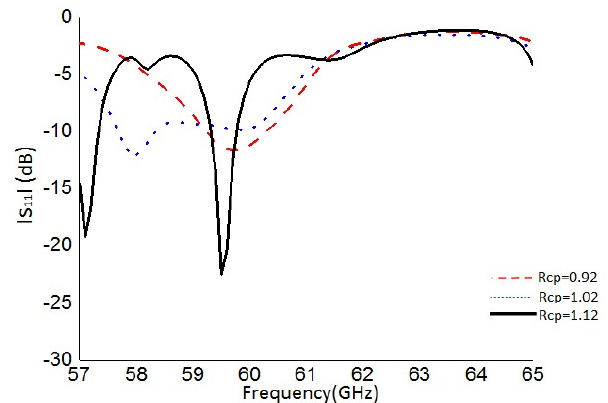
Figure 6. Simulated return loss for the proposed antenna with various radii of the circular slot (unit in mm).